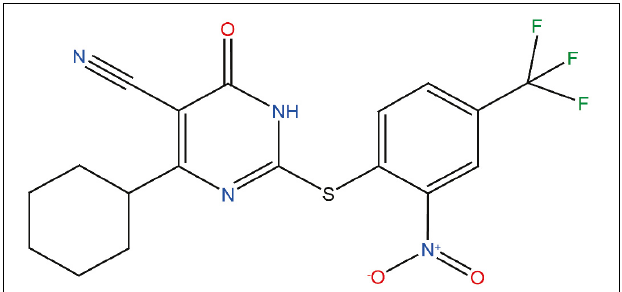
FIGURE 1 | Chemical structure of the compound ZPD-2. ZPD-2 corresponds to 4-cyclohexyl-2-((2-nitro-4-(trifluoromethyl)phenyl)thio)-6-oxo-1,6-